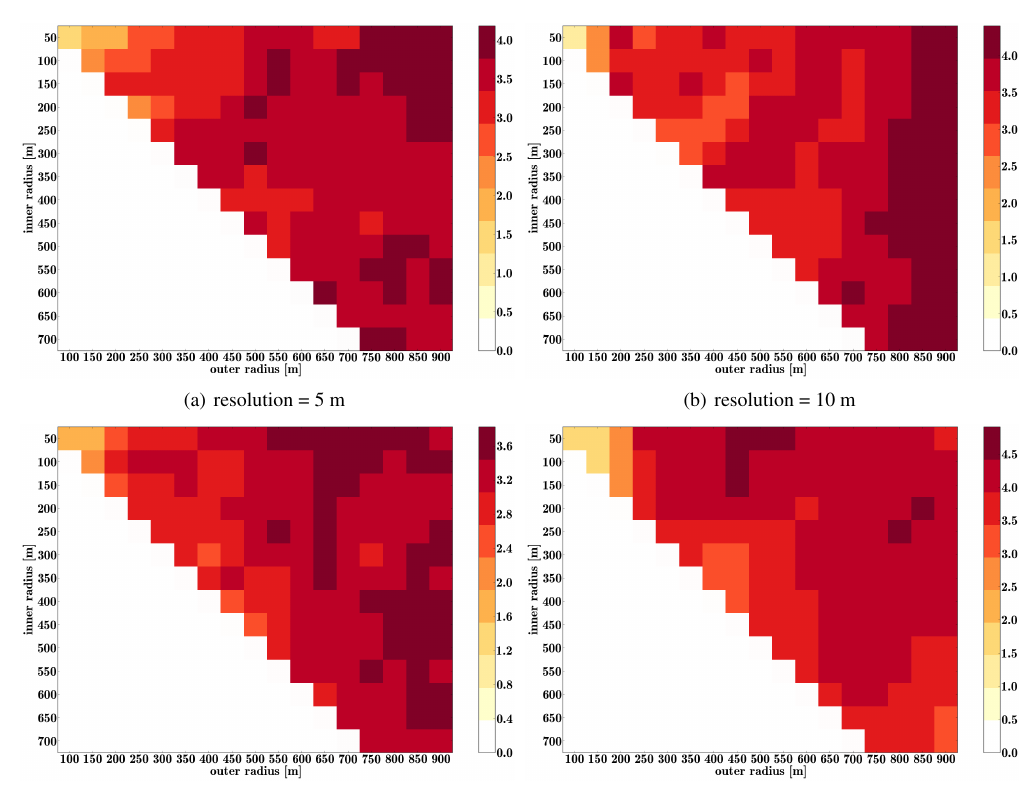
Figure 7: affected households [%] Class 1 - Class 6 for different